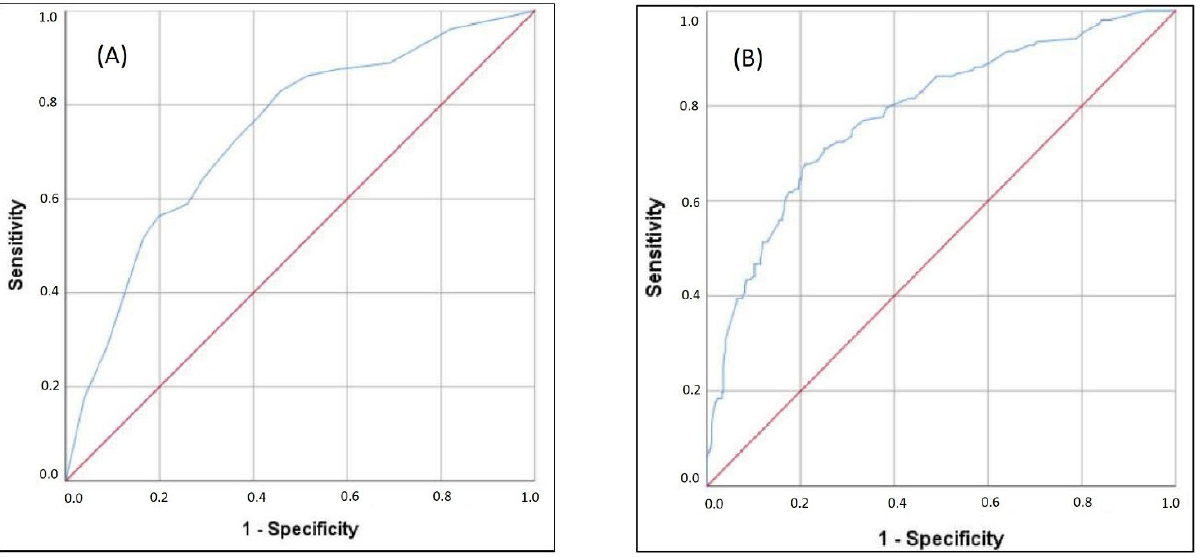
Figure 1. ROC analysis of ( A ) multiple regression model and ( B ) expanded multiple regression model in predicting mortality .